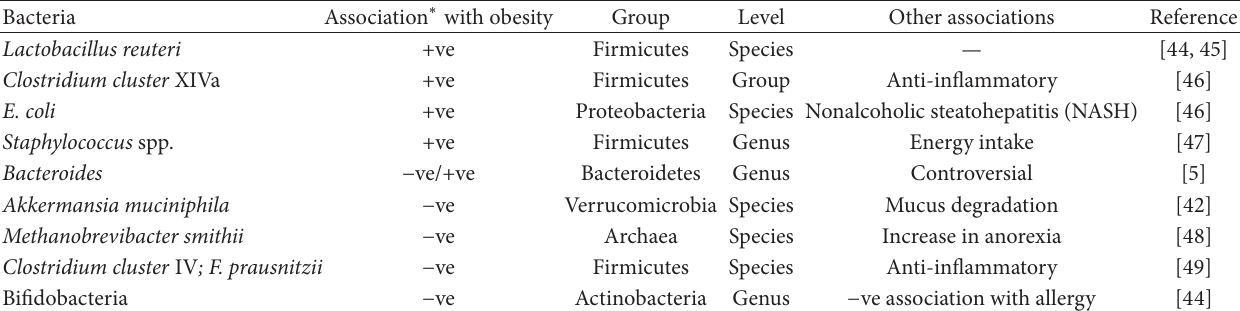
Table 4: Association of gut microbial species/genera with obesity or leanness in human